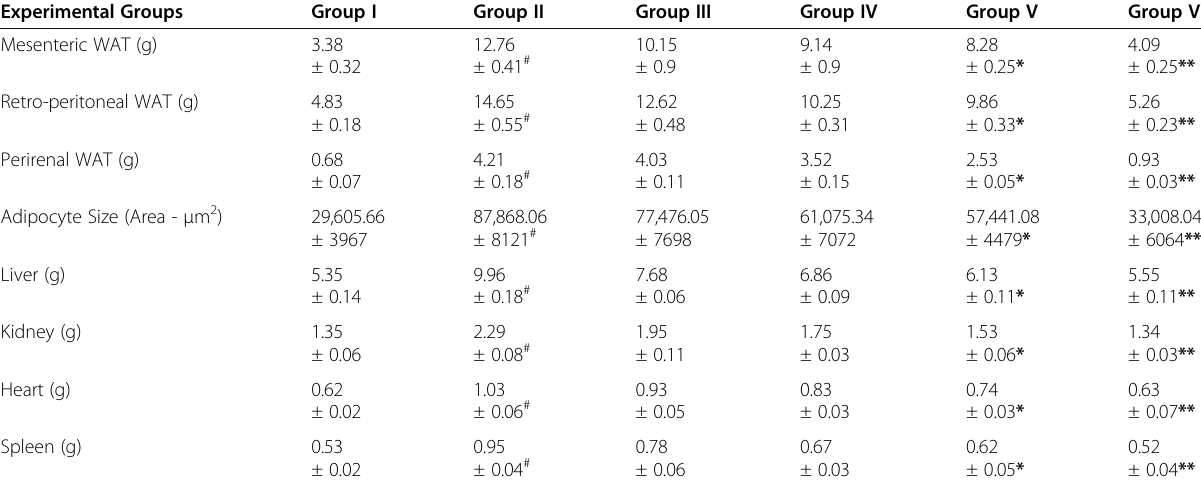
Table 1 Fat Pad Weights, Adipocyte Size and Organ Weights of Experimental Rats Experimental